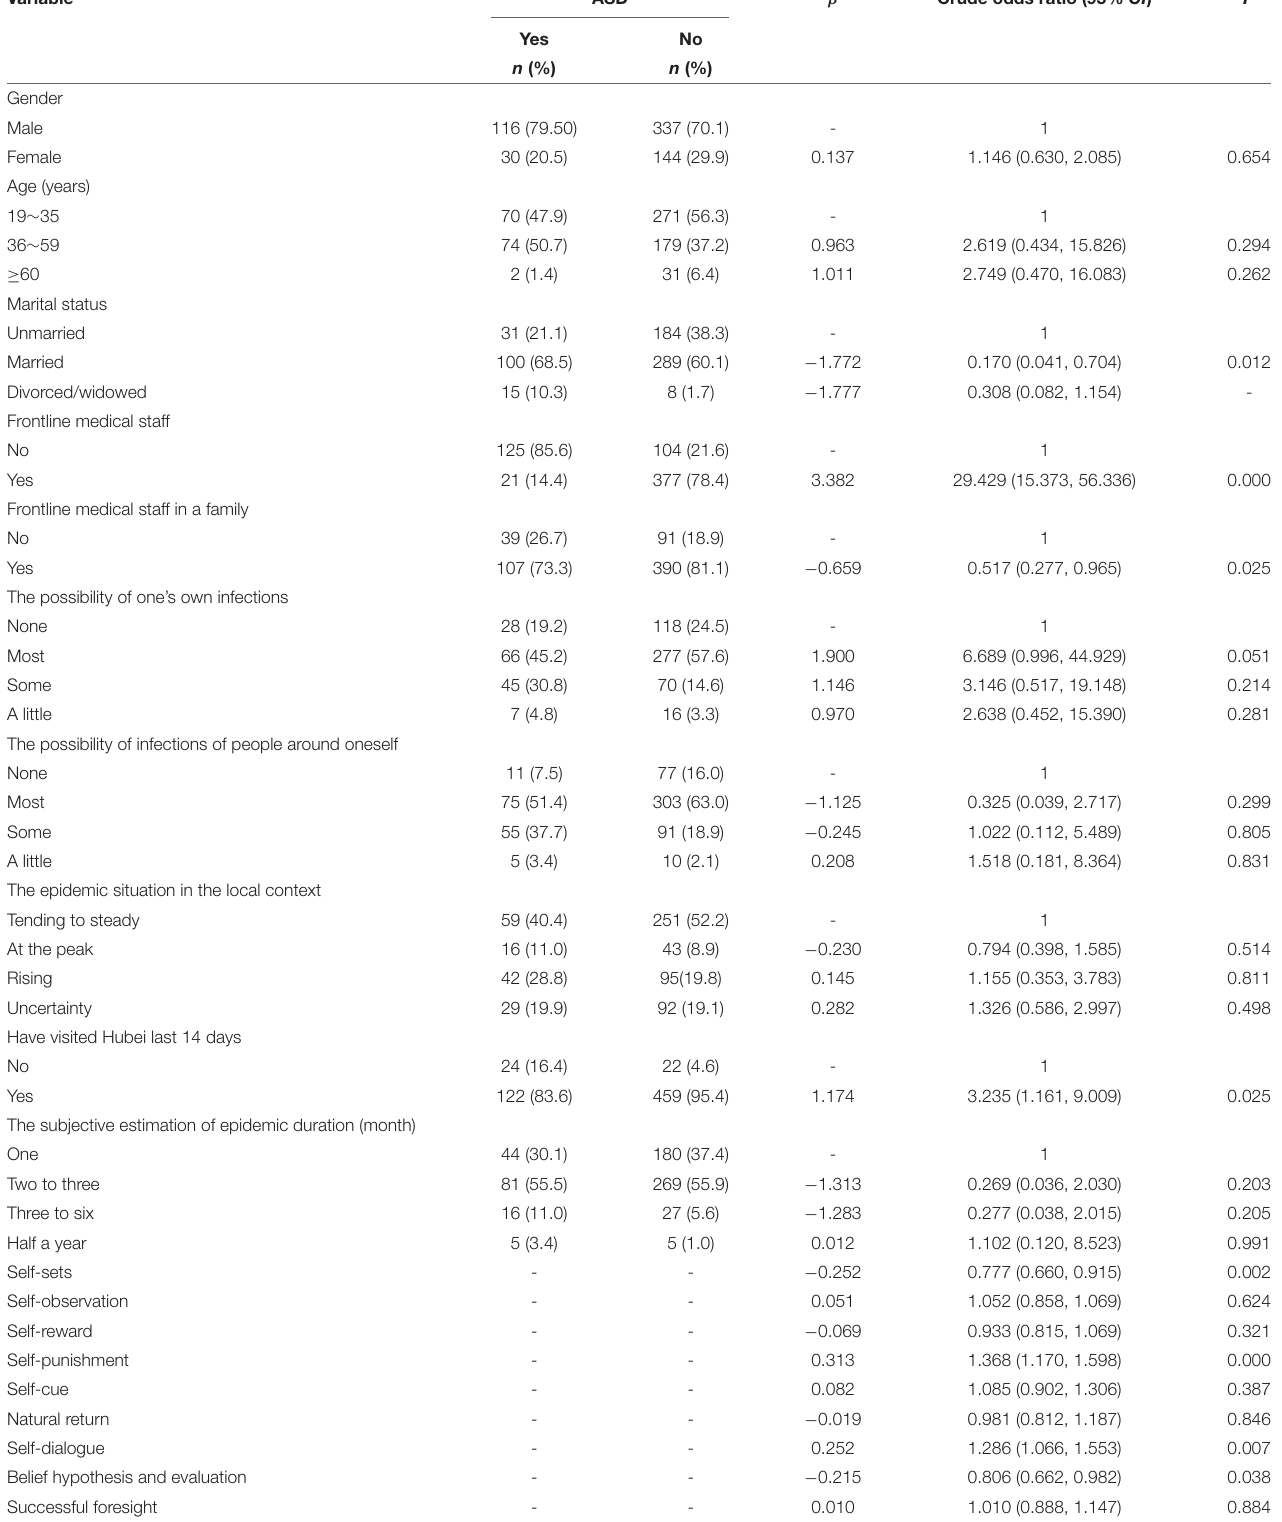
TABLE 4 | Binary logistics regression analysis of influencing factors of ASD in medics ( n = 627).